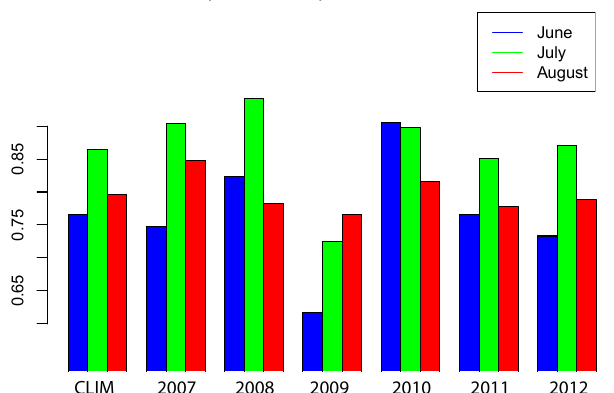
Figure 6. Same as Fig. 5 for 300hPa potential vorticity (PVU) taken from 12h ERA-Interim reanalysis.